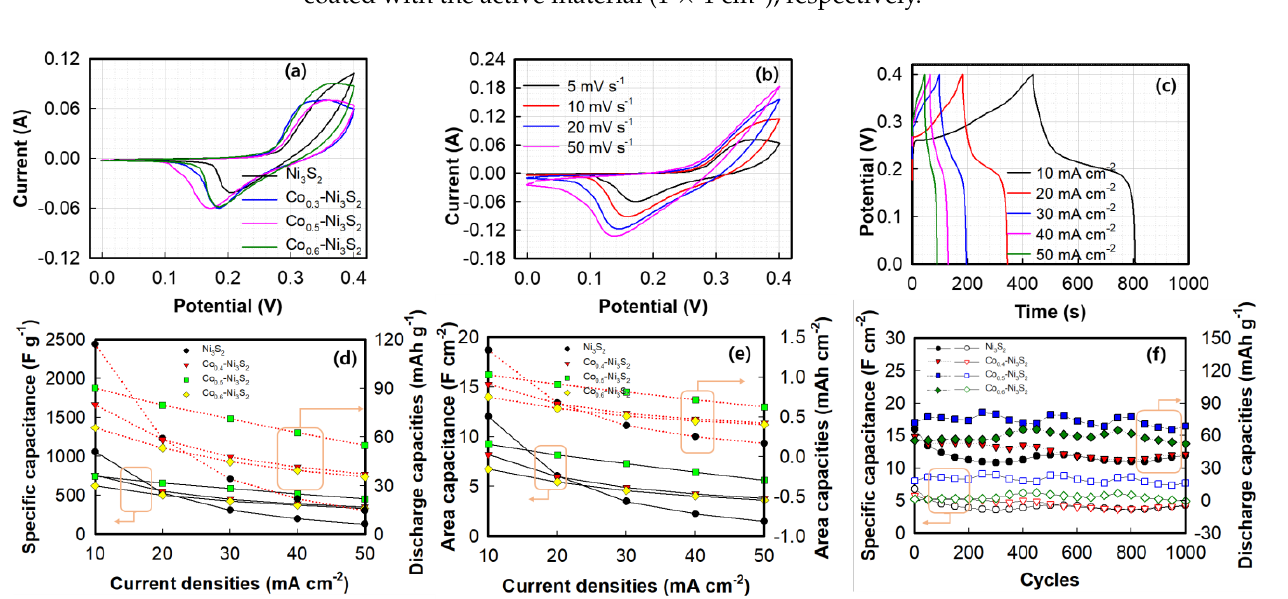
Figure 6. Cyclic voltammograms of ( a ) different electrodes at 5 mV s −1 , ( b ) Co 0.5 –Ni 3 S 2 at different scan rates, ( c ) galvanostatic charge–discharge of Co 0.5 –Ni 3 S 2 electrode, ( d ) specific capacitances and capacities, ( e ) area capacitances and capacities, and ( f ) cycling performances at 20 mA cm −2 .